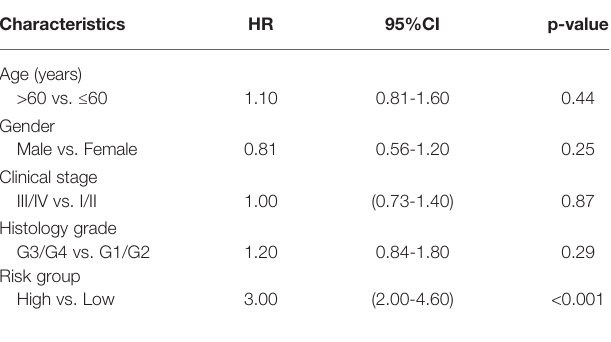
TABLE 5 | The multivariate analyses of overall survival according to risk group, after adjusting for other potential predictors in TCGA. Characteristics HR